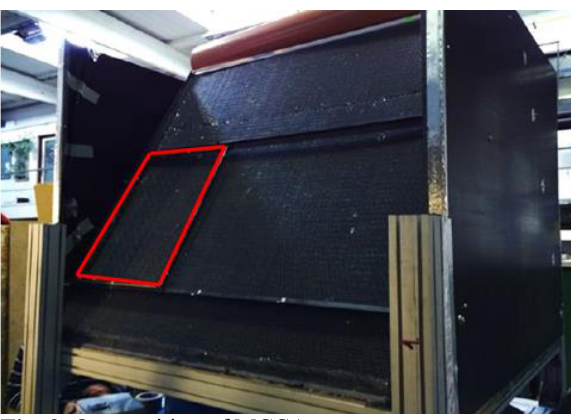
Fig. 3. One position of MCCA Every position in which air flow rate was measured is in the scheme in Figure 4.